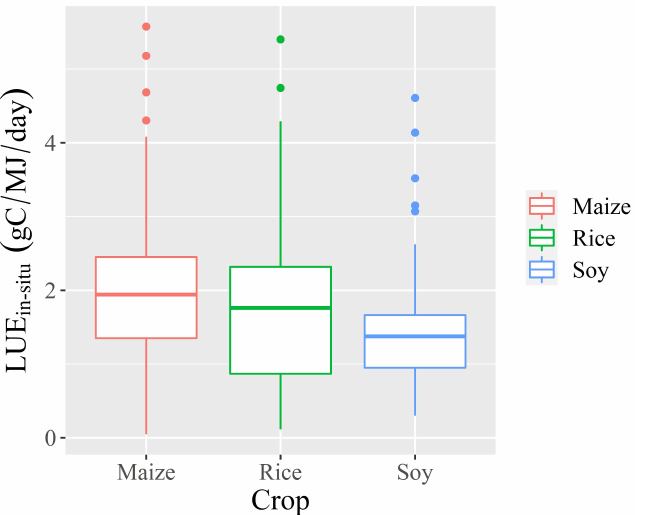
Figure 2. Distribution of in situ light use efficiency values derived from flux tower sites for maize, rice, and soy crops